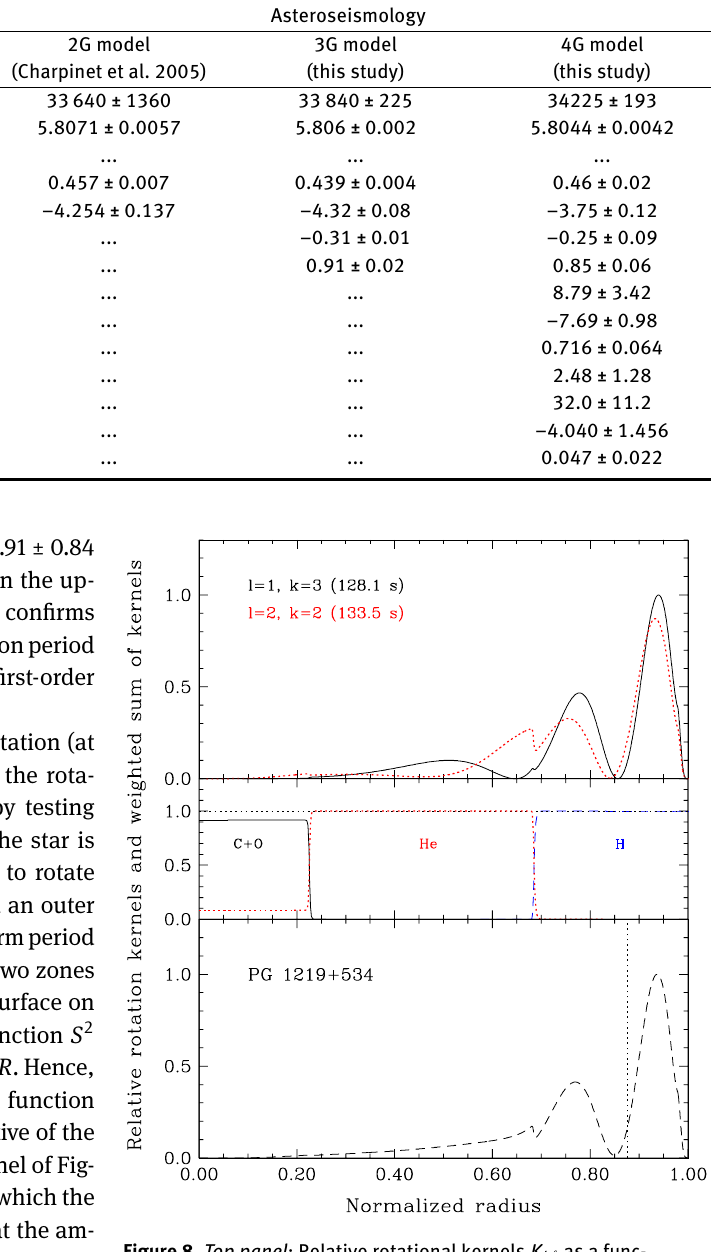
Figure 8. Top panel : Relative rotational kernels K k ℓ as a func- tion of normalized radius for the two multiplet structures associ- ated to 128.1 s and 133.5 s periods observed in the light curve of PG1219+534. Middle panel: Chemical stratification of the model. Bottom panel: Weighted sum of the kernels versus normalized ra- dius. The vertical dotted line defines the layer where half of the running integral of the weighted sum is below and the other half